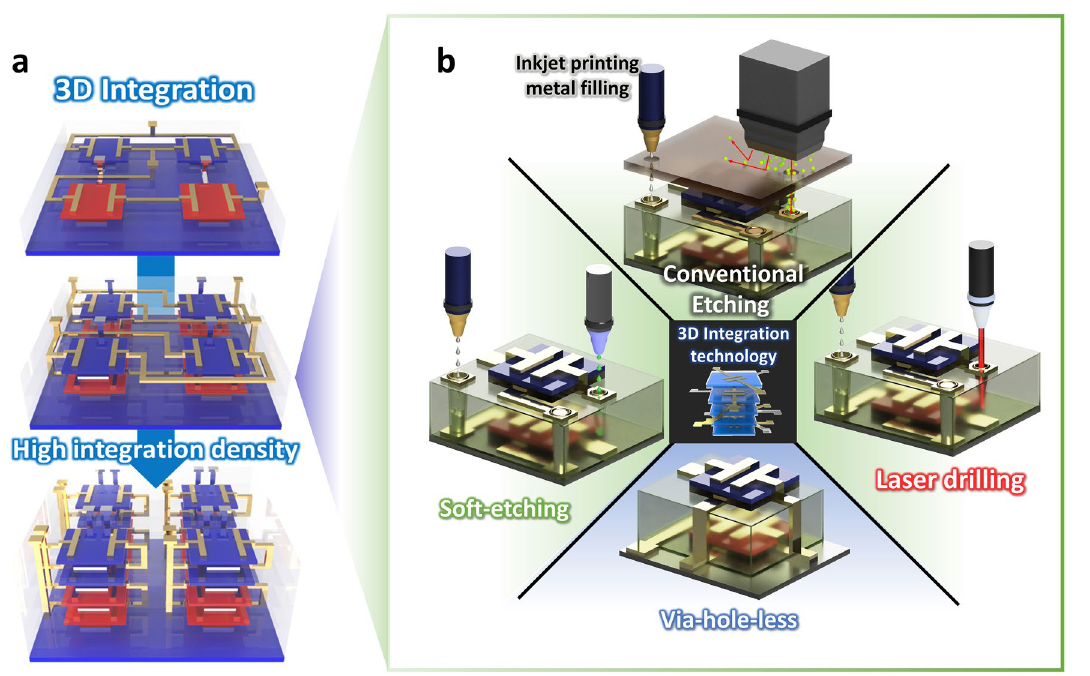
Fig. 2 a Via-hole-based and b via-hole-less metal interconnection schemes for vertical integration to improve the integration